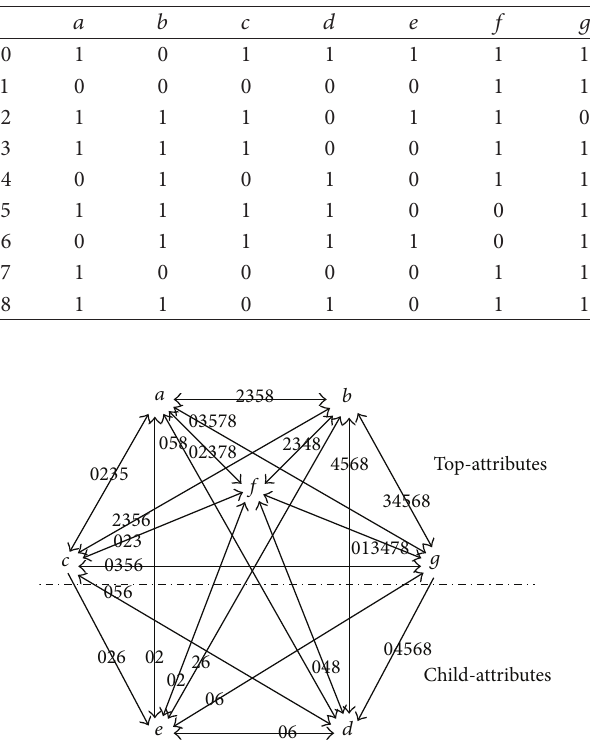
Figure 1: The attribute topology of the formal context from Table